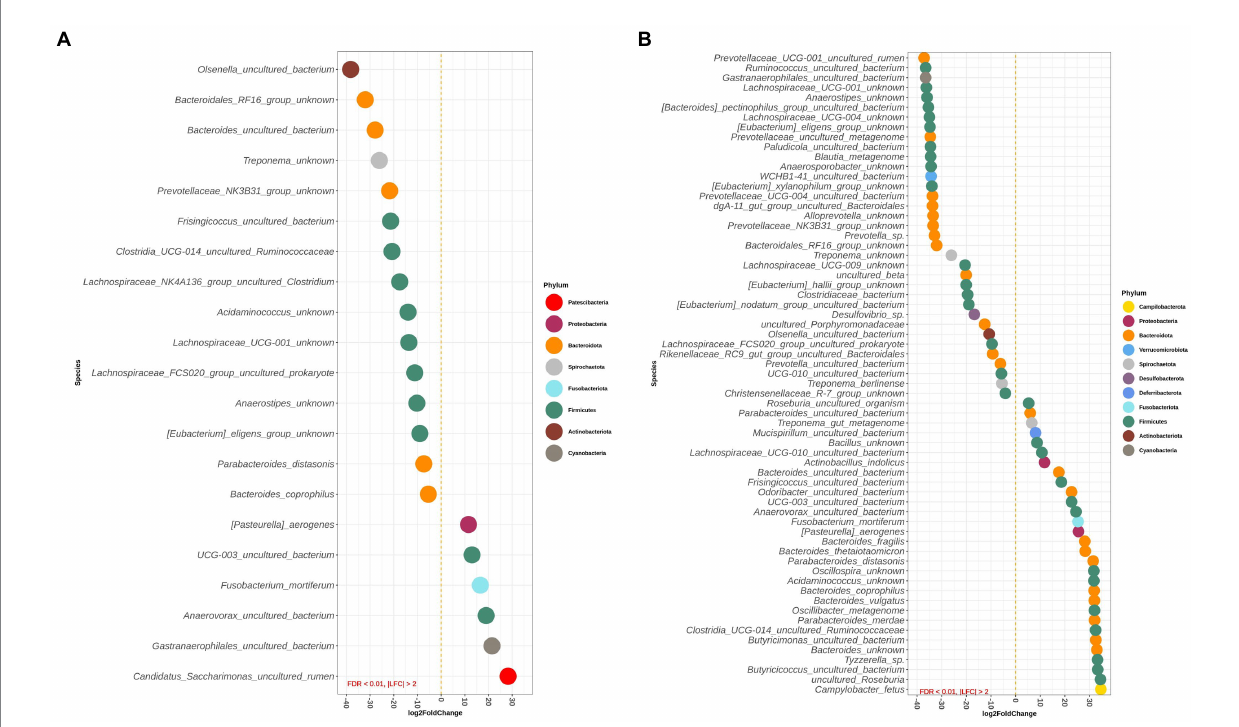
FIGURE 4 Waterfall plot for differentially abundant species of the main effect of diet (westernized diet groups vs. non-westernized diet groups; A ) and DexSS (DexSS groups vs. non-DexSS groups; B ). Different colors represent different phyla. Only species with |LFC| > 2 and FDR < 0.01 are presented.